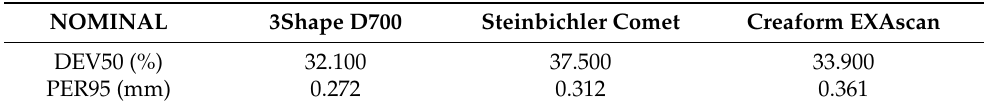
Table 2. Comparison with the nominal STL model.